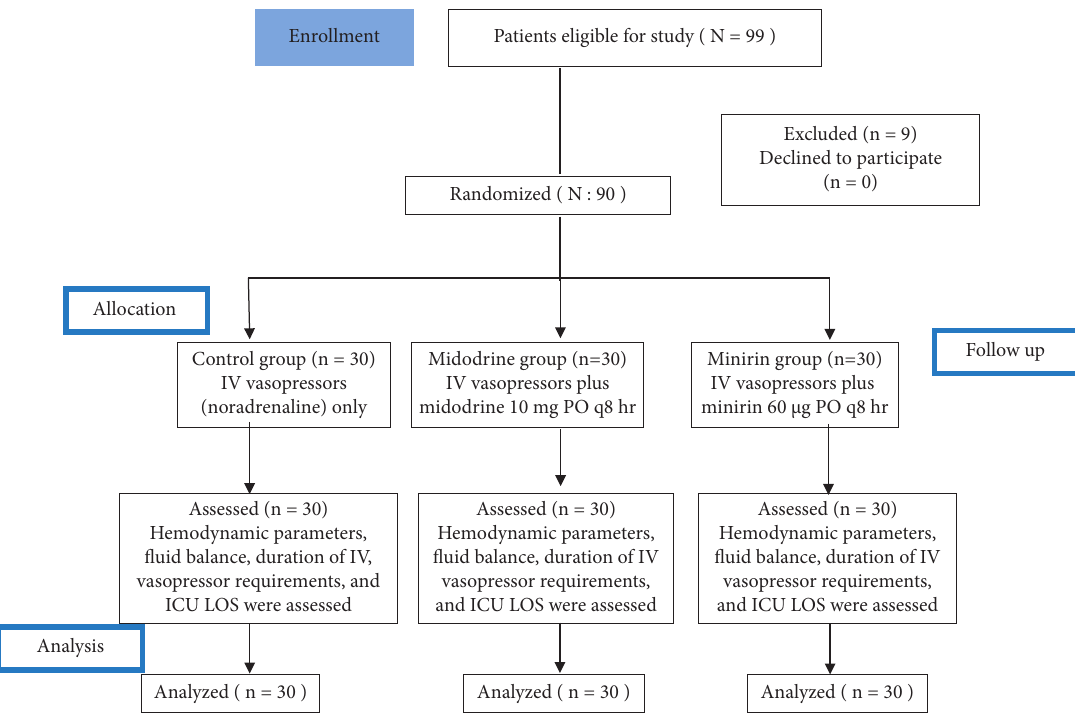
Figure 1: CONSORT flow diagram of a randomized controlled